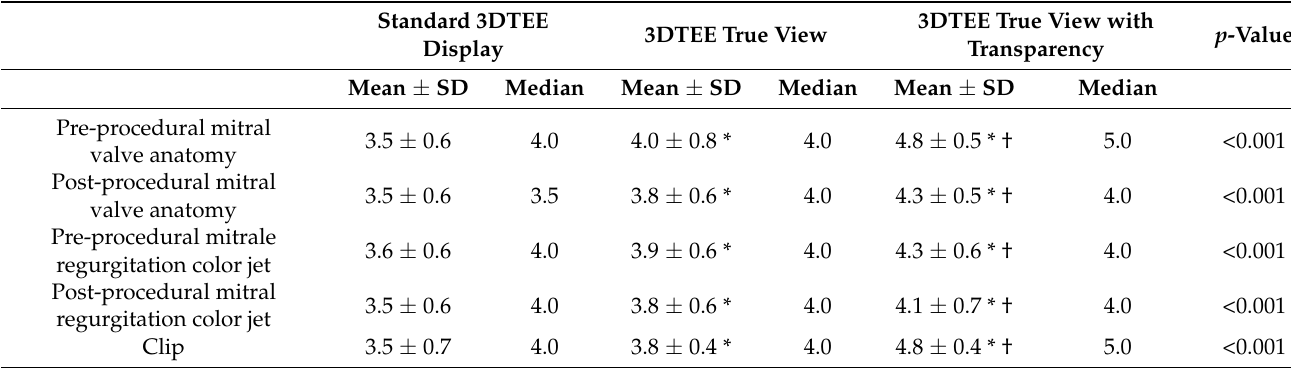
Table 2. Quality score comparison (Likert scale from 1, the worst, to 5, the best) among the three different 3DTEE display modalities in the anatomical features definition.